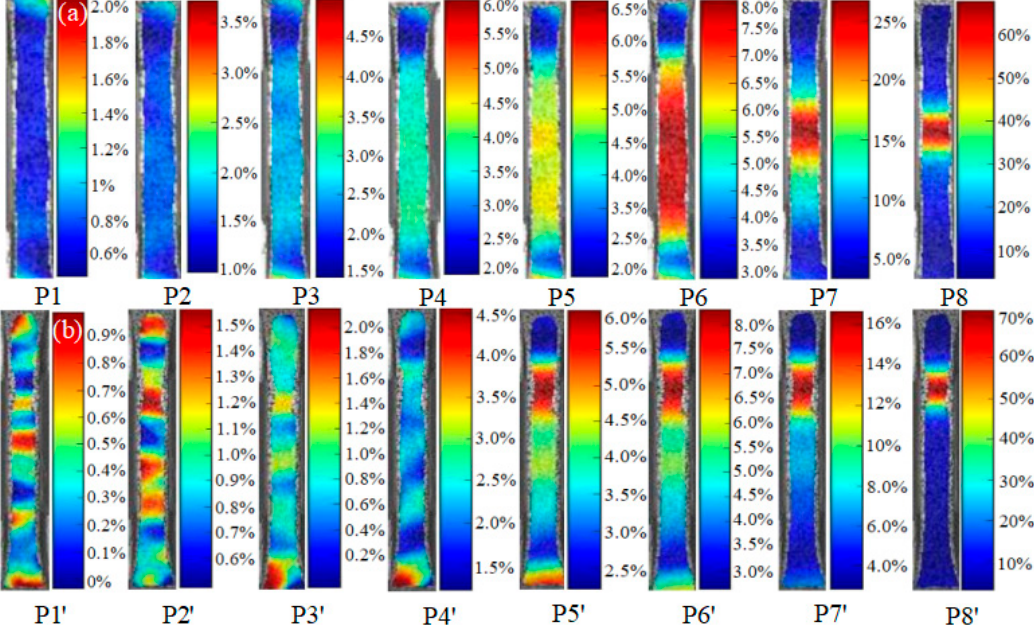
Figure 11. Strain evolution of transversal and longitudinal specimens during the tensile test. ( a ) Transversal specimen; ( b ) longitudinal specimen.